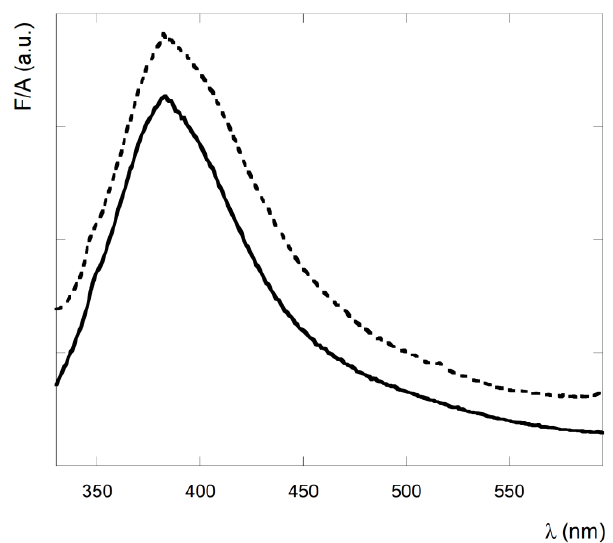
Figure 5. Fluorescence spectrum of peptide 1 fibrillar nanostructures in CH 2 Cl 2 solution at a concen- Figure 6. Fluorescence excitation spectrum of peptide 1 in CH 2 Cl 2 solution at a concentration of tration of 2.8 × 10 −3 M. According to Ref. [61] the fluorescence emission spectrum of the filaments 2.8 × 10 − 3 M. λ em = 400 was obtained by exciting the sample at  ex = 315 nm. Continuous line: fresh solution, dotted line: solution after ten days.